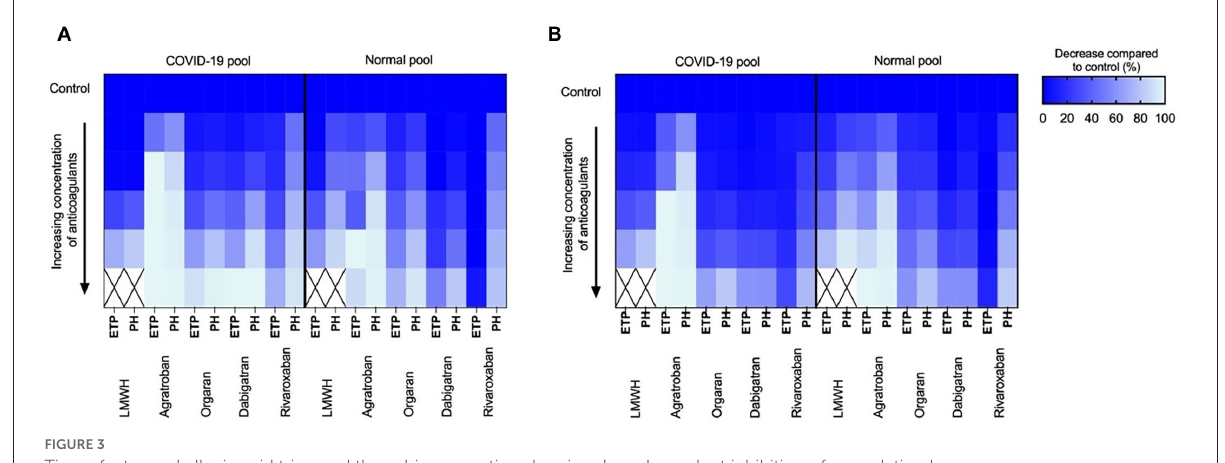
FIGURE3 Tissue factor and ellagic acid triggered thrombin generation showing dose dependent inhibition of coagulation by low-molecular-weight-heparins (LMWH; 0.3–1.2 IU/ml), Argatroban (0–4 µ g/ml), orgaran (0–1.6 U/ml), dabigatran (0–320ng/ml) and rivaroxaban (0–320ng/ml) in normal pool plasma and COVID-19 pool plasma spiked with 0.3 IU/ml LMWH. Color scheme indicates the reduction (0–100%) in endogenous thrombin potential (ETP) and peak height (PH) upon increasing concentration of inhibitors compared to control (100%). (A) Inhibition of tissue factor triggered thrombin generation and (B) Inhibition of ellagic acid triggered thrombin